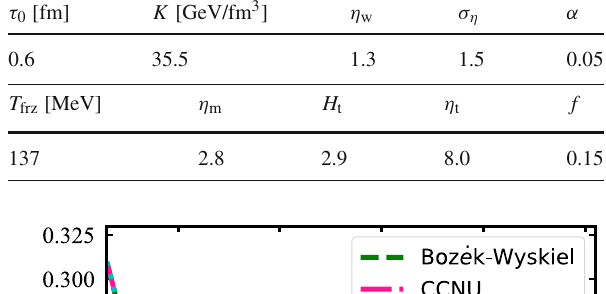
Table 1 Model parameters for the hydrodynamic evolution [51] for √ s NN = 200 GeV with impact parameter b = Au–Au collisions at 6 . 7 fm, among which η m is for our Case (A), H t and η t are for Case (B), and the other parameters are commonly applied to all models here